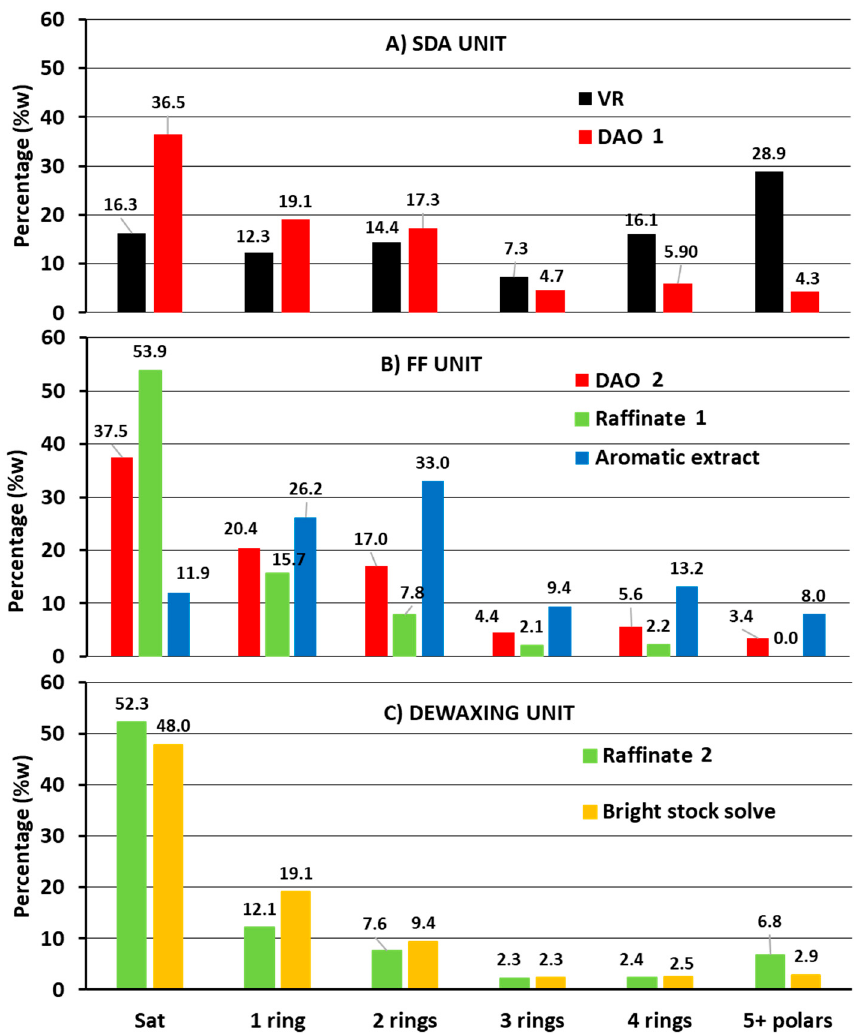
Figure 2. Percentage (%w) of saturate and aromatics by high performance liquid chromatography (HPLC) with an evaporative light scattering detector (ELSD) (HPLC3) for solvent de-asphalter (SDA) ( A ), furfural (FF) ( B ) and ( C ) DEWAXING units.